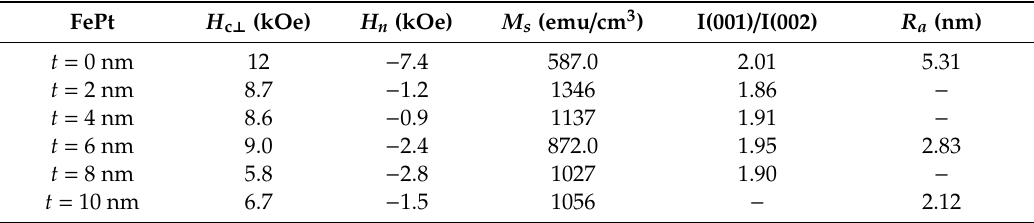
Table 1. Out of plane H c , nucleation field ( H n ), saturation magnetization ( M s ), Integrated intensity ratio (I(001) / I(002)), surface roughness ( R a ) of FePt(t nm) / [MgTiTaON(1 nm) / FePt(4 nm)] 2 / MgTiON / CrRu